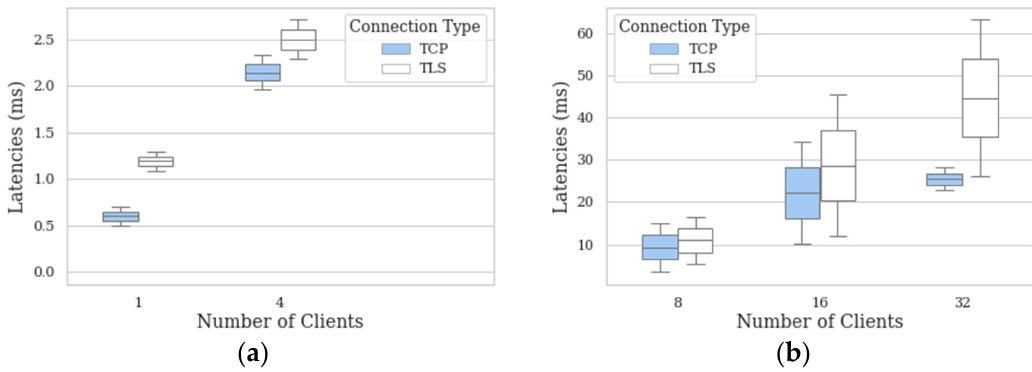
Figure 6. Latencies’ measurements in the fourth phase for the following architectures: ( a ) 1:1 and 4:1; ( b ) 8:1, 16:1 and 32:1.